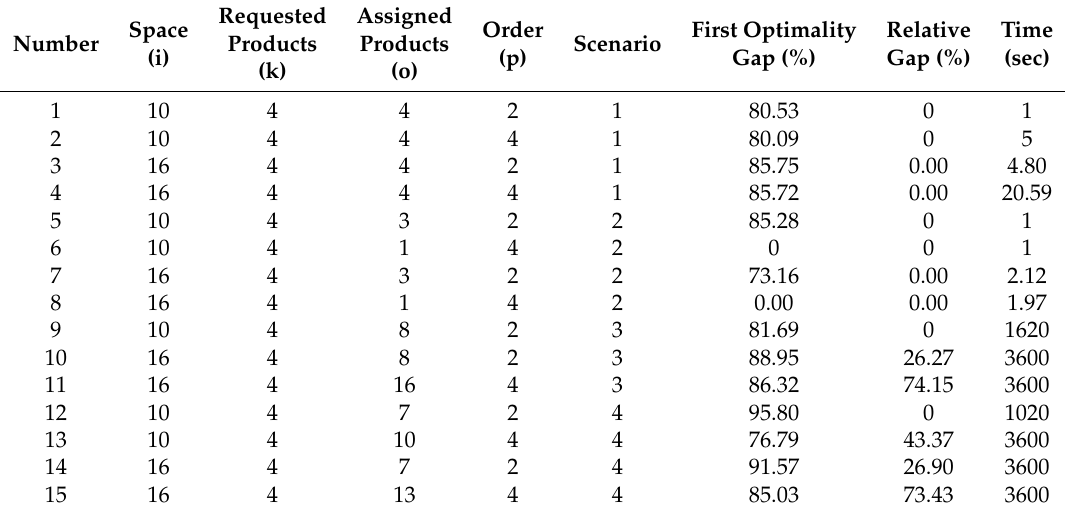
Table 2. Results for small size